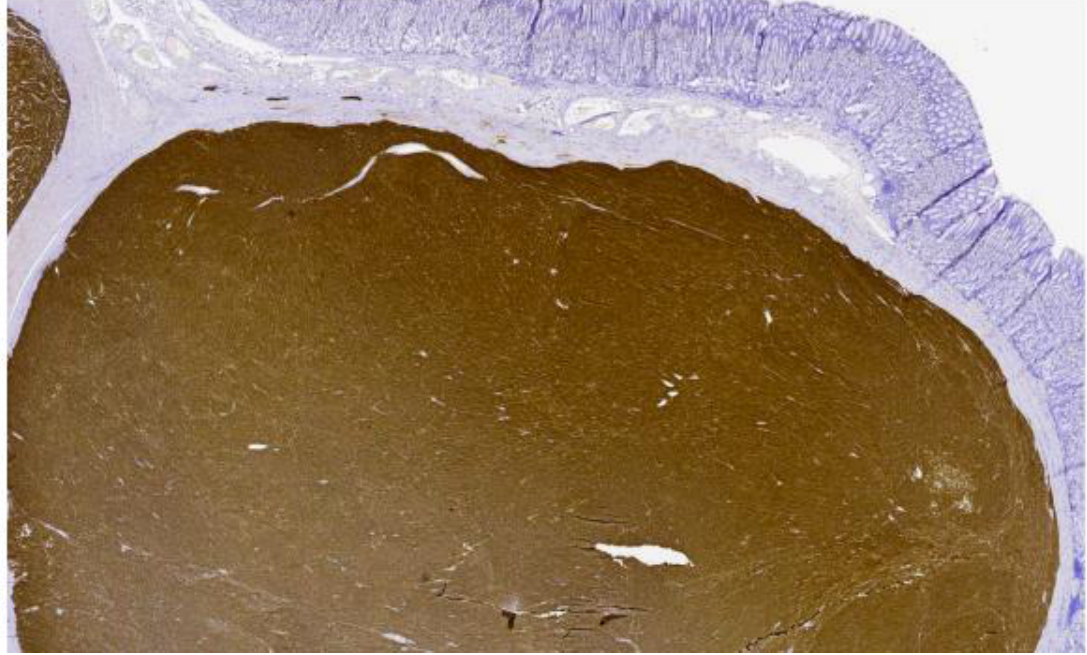
Figure 2. Pathological cut of gastric GIST with immunohistochemistry stain for CD117/c-kit.